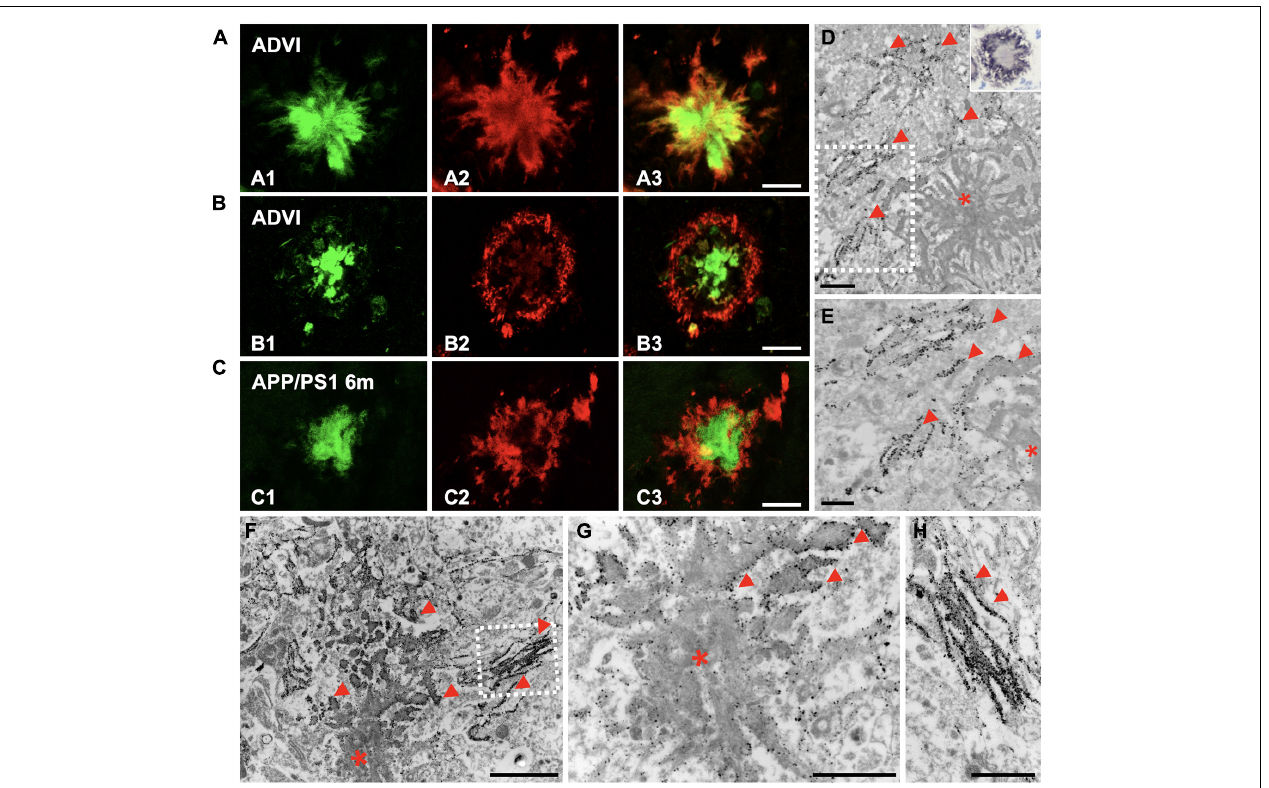
FIGURE 6 | Oligomeric forms of A β were located at the plaque periphery in both AD and APP/PS1 hippocampi. (A,B) Confocal double-fluorescent staining with Thioflavin-S [ (A1,B1) green] and OC antibody [ (A2,B2) red] revealed that oligomeric A β was mainly detected at the plaque periphery, depicting a halo around the fibrillar core in CA1 region of Braak VI brains (A3,B3) . (C) Likewise, OC immunoreactivity showed the same disposition in plaques of 6-month-old APP/PS1 mouse hippocampus (C1–C3) . (D) A β immunogold labeling (OC antibody) observed by TEM was found at the plaque border (red arrowheads; asterisk, A β deposit). Detail at higher magnifications in panel (E) . Inset in panel (D) . Detail of a plaque from CA1, immunostained for amyloid oligomers (OC antibody) in a semithin section from a 6-month-old APP/PS1 mouse. Counterstained with Harry’s hematoxylin. (F–H) Immunogold for 12–24 mers A β (NU-4) confirmed the presence of these specific amyloid oligomeric forms in the edge and peripheral threads of extracellular A β deposits (red arrowheads). Panel (H) depict details from panel (F) . Scale bars, (A–C) 25 µ m; (D,G–H) 1 µ m, (E) 0.5 µ m; (F) 2 µ